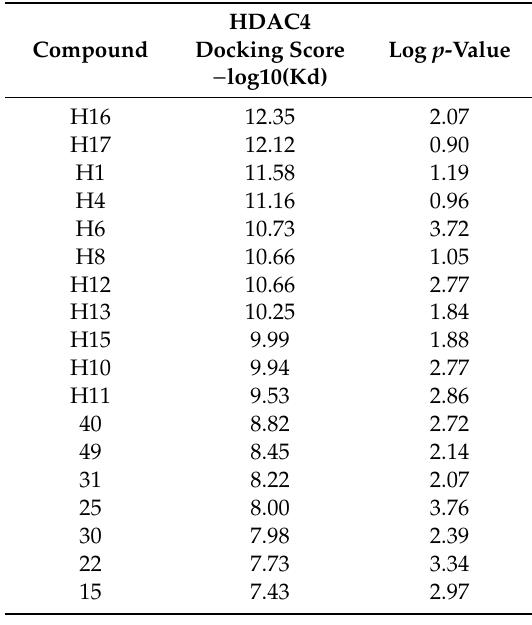
Table 6. Docking scores of our designed cyclopropane hybrid derivatives in HDAC4 and HDAC5